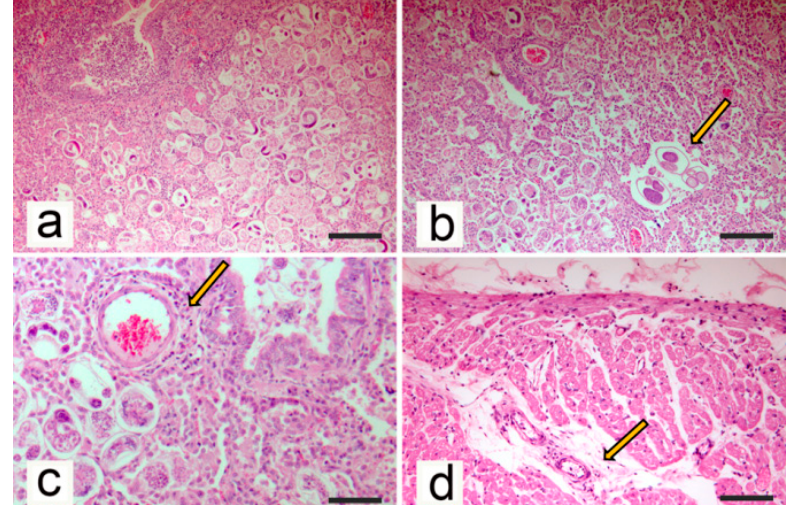
Figure 5. Histopathological findings from the examined kitten. ( a ) Lung. Alveolar lumen filled with eggs and larvae (Haematoxylin-Eosin stain, bar = 100 μ m). ( b ) Lung. Scattered adult Aelurostrongylus abstrusus (arrow) were present within the inflammatory tissue, where the alveoli were filled by morulated eggs (Haematoxylin-Eosin stain, bar = 100 μ m). ( c ) Lung. Absence of smooth muscle hypertrophy of arteriolar wall and presence of mild inflammatory cell infiltrate in the periarteriolar area (arrow; Haematoxylin-Eosin stain, bar = 50 µ m). ( d ) Heart. Myocardial oedema with myocardiocyte spacing and presence of mild inflammatory infiltrates located in the periarteriolar areas (Haematoxylin-Eosin stain, bar = 100 μ m).